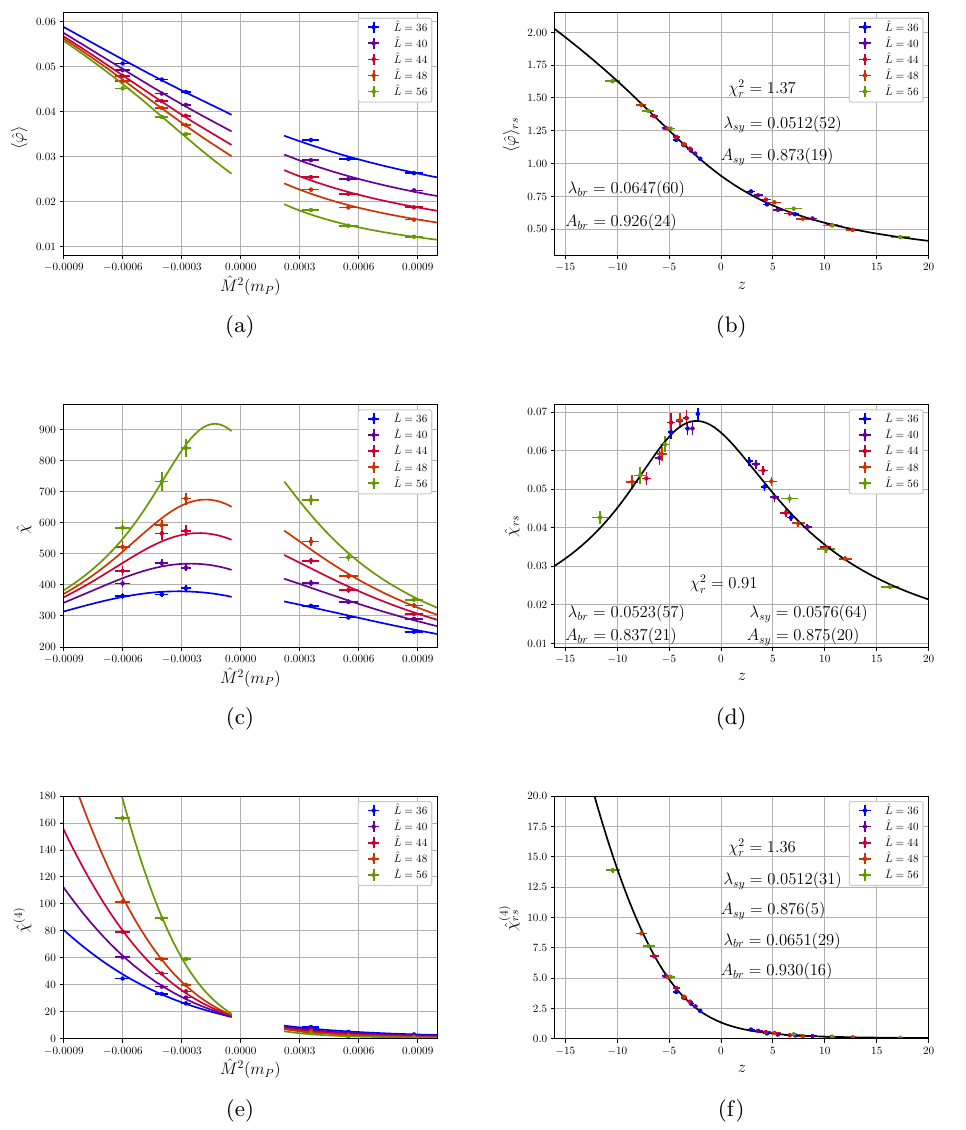
Figure 4 . Results of the scaling tests via (cid:12)tting and (3.7) are displayed in (a), (c) and (e). The corresponding rescaled quantities de(cid:12)ned in eqs. (3.19), (3.20) and (3.21) are plotted against the scaling variable in (b), (d) and (f).